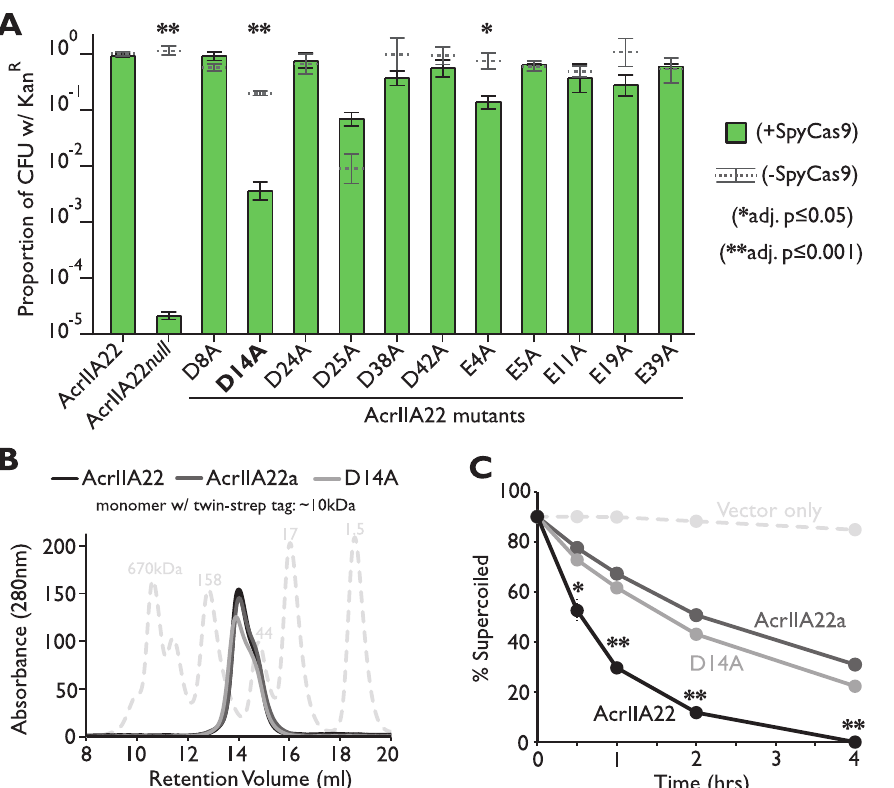
Fig 6. Impaired nicking activity of AcrIIA22 variants in vitro correlates with lower SpyCas9 inhibition in vivo. ( A ) Alanine mutagenesis of acidic amino acid residues (glutamic acid or aspartic acid) in AcrIIA22 reveals that D14 is important for plasmid protection against SpyCas9. Asterisks depict statistically significant differences in plasmid retention under SpyCas9-inducing and noninducing conditions, per the legend at right. The D14A mutant is significantly impaired, the E4A mutant is slightly impaired, whereas all other mutants are not impaired for plasmid protection against SpyCas9 compared to an uninduced control. All p -values were corrected for multiple hypotheses using Bonferroni method (Student t test, n = 3). ( B ) AcrIIA22 (black), AcrIIA22a (dark gray), and a D14A mutant (light gray) all elute with similar oligomer profiles via SEC. The dashed trace depicts protein standards of the indicated molecular weight, in kDa. ( C ) AcrIIA22a and the D14A mutant are impaired for nicking relative to AcrIIA22. All experiments were performed in triplicate, with standard deviations indicated by dashed lines (in most cases, the data points obscure these error bars). Asterisks denote cases where AcrIIA22 is significantly different than both AcrIIA22a and the D14A mutant after correcting for multiple hypotheses (Student t test, n = 3, Bonferroni correction). A single asterisk ( � ) means that adjusted p -values for both comparisons are below 0.05. A double asterisk ( �� ) means that adjusted p -values are both below 0.005. S10G and S10H Fig show representative gels for these nicking experiments. The individual numerical values that underlie the summary data in this figure may be found in S1 Data. CFU,